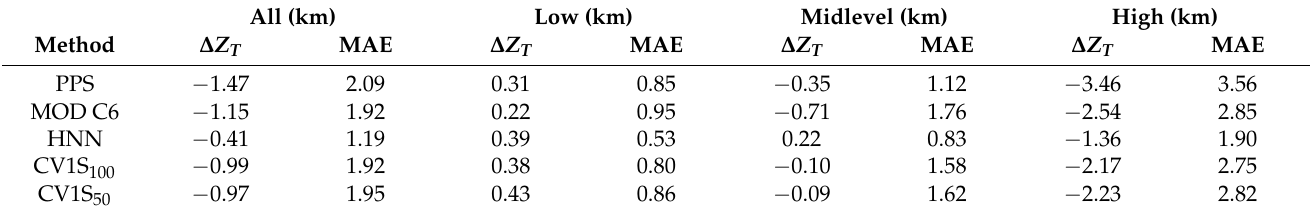
Table 8. Error summary for four CTH retrieval products relative to CALIOP VFM product: Bias ( ∆ Z T ) and mean absolute error (MAE). Results for PPS, MOD C6, and HNN adapted from [12]. CV1S results based on 1 km JAJO 2015–2016 data, | ∆ t | ≤ 15